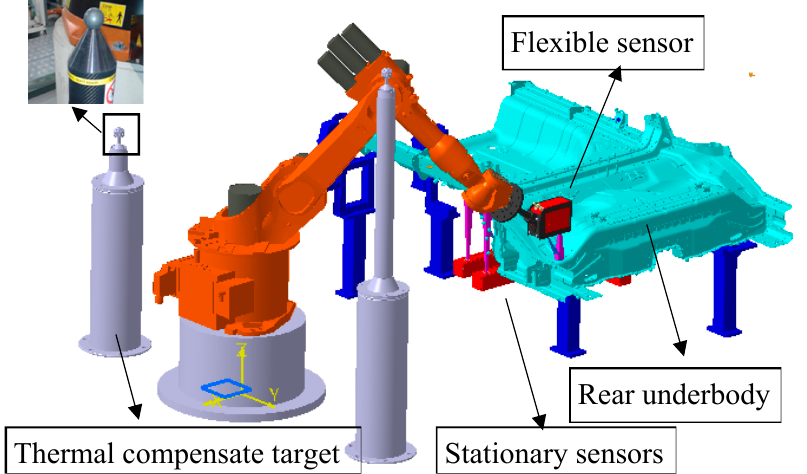
Figure 4. 3D model of the hybrid visual inspection station.